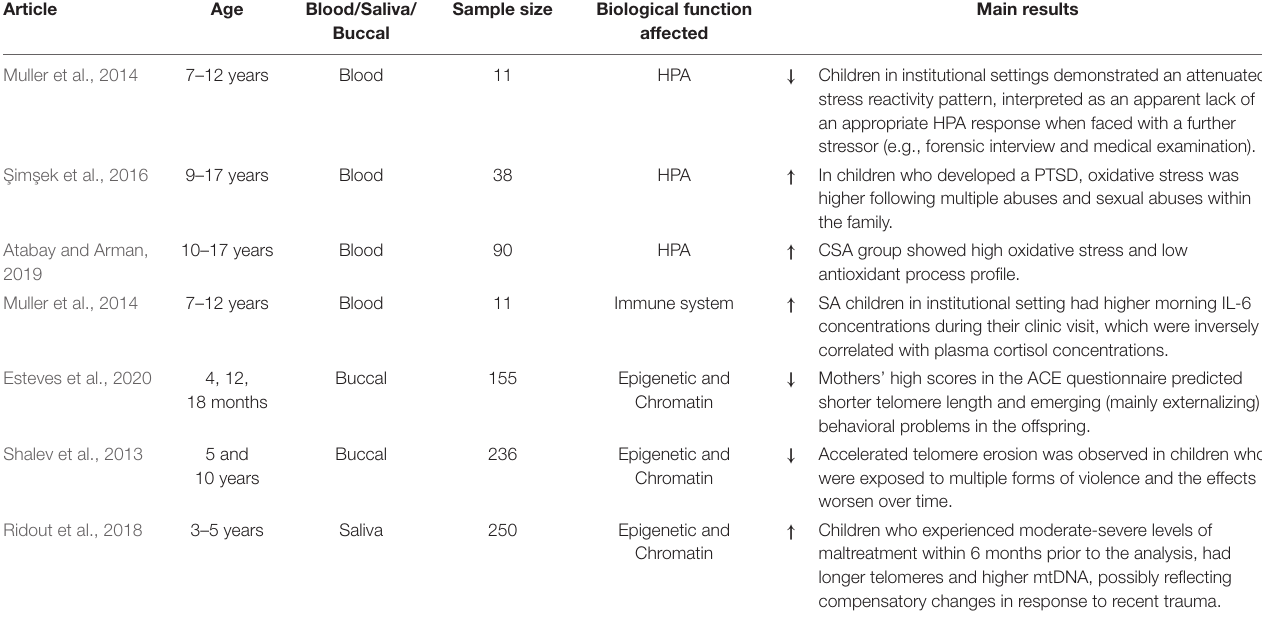
TABLE 1 | Short-term biological consequences of childhood sexual abuse (CSA)